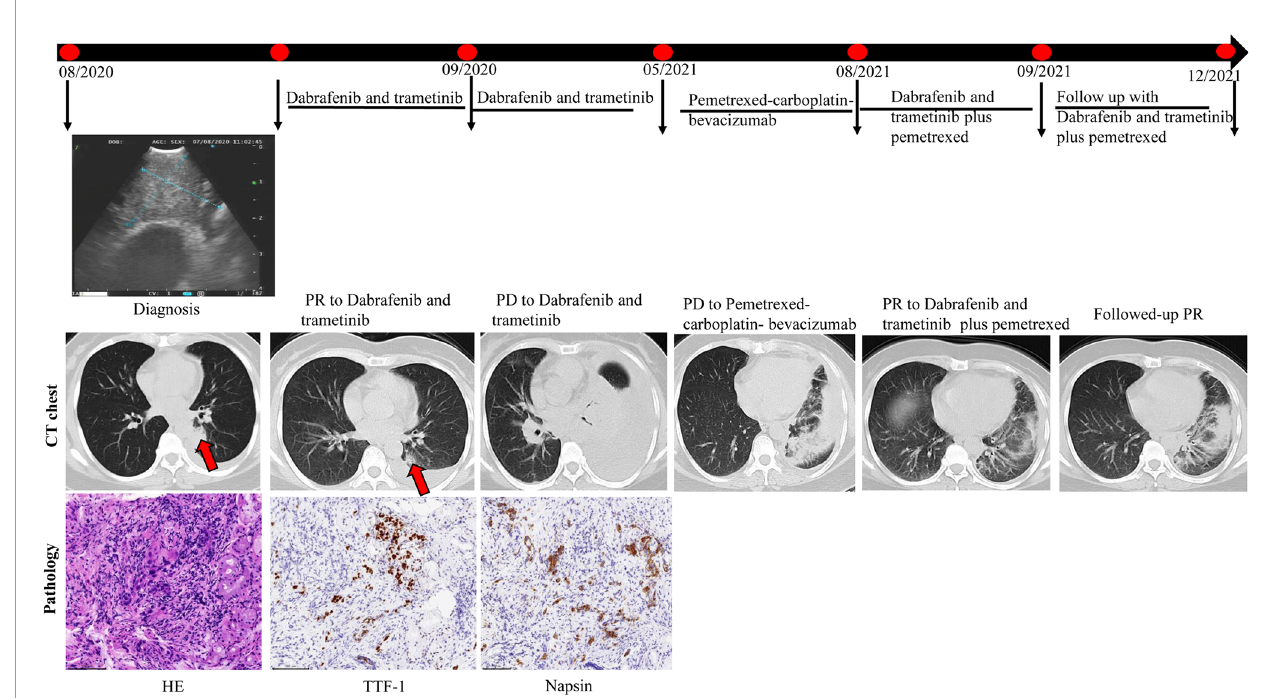
FIGURE 5 | Computed tomography (CT) imaging reveals initial and re-challenge response to dabrafenib-trametinib combination